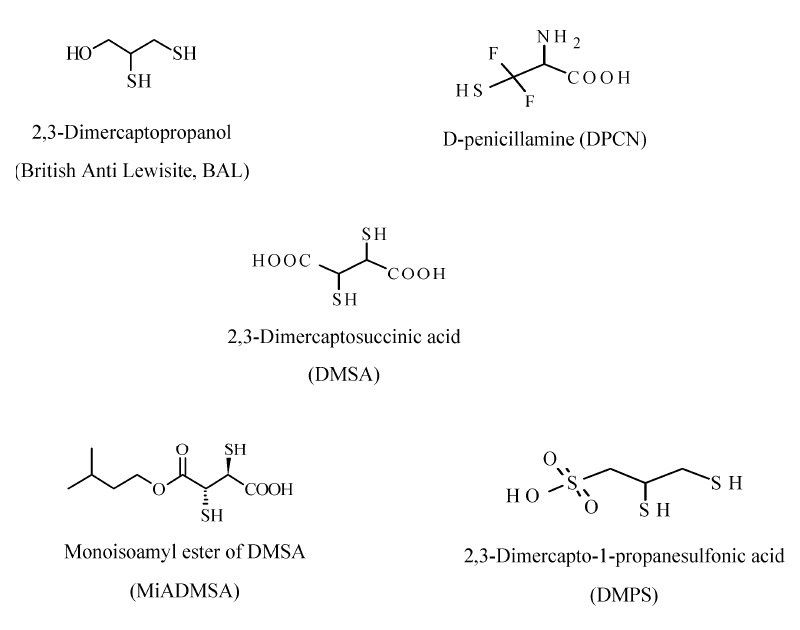
Figure 4. Structures of common substrates chelating mercury.